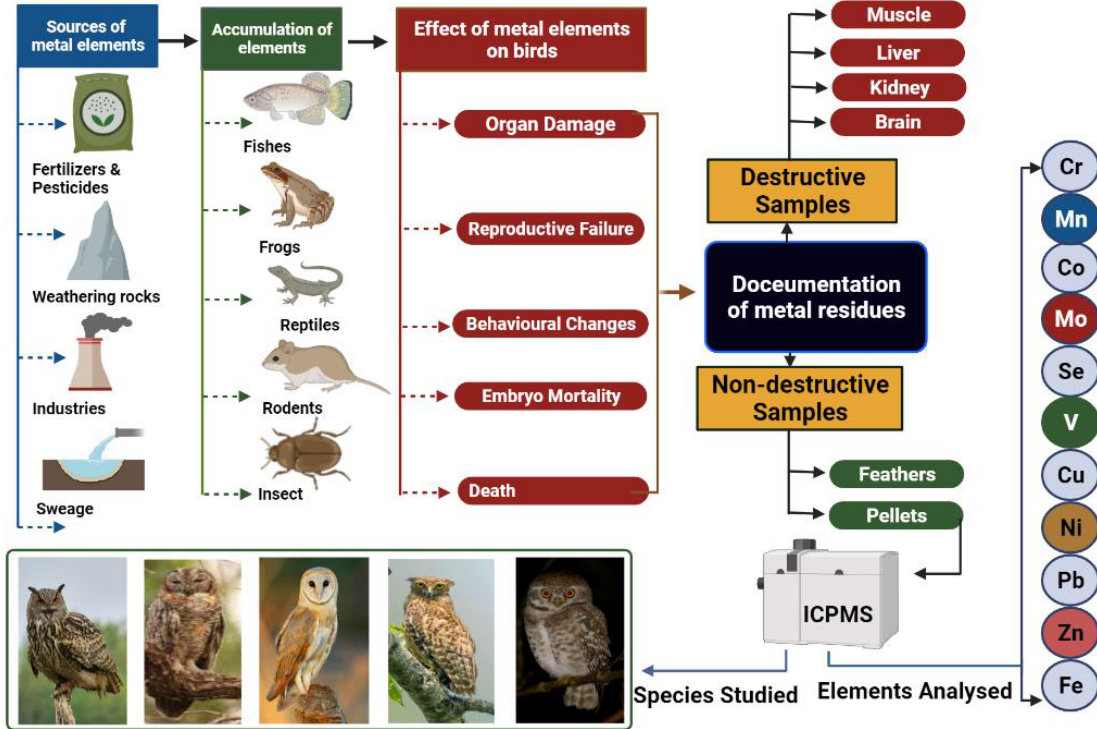
Figure 1. Impacts of metals on birds and the mechanisms behind them.